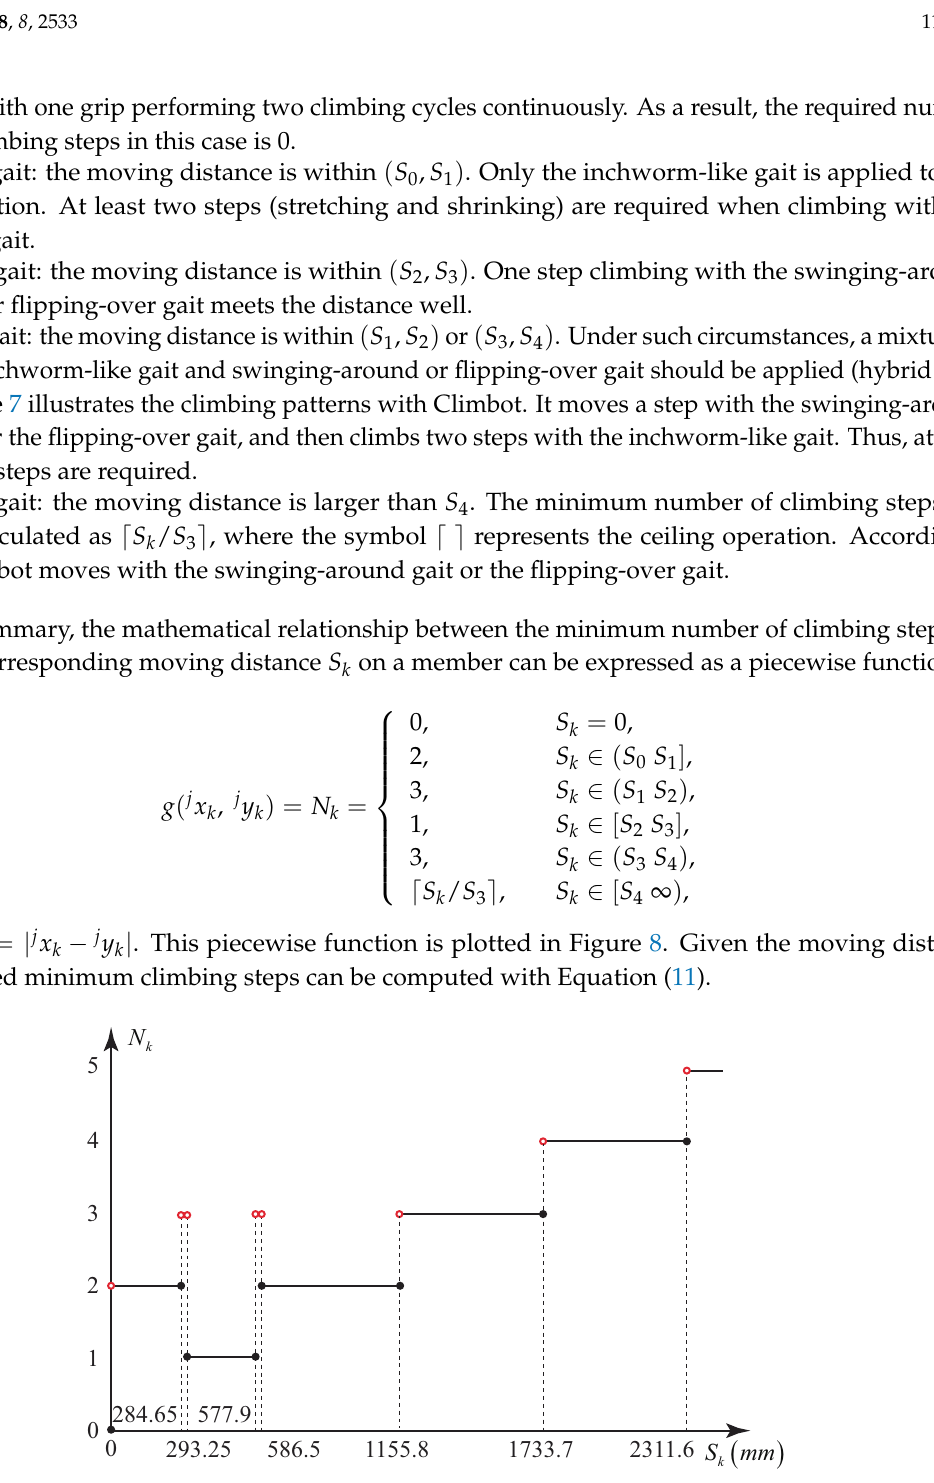
Figure 8. The relationship between moving distance (on a member) and minimum climbing